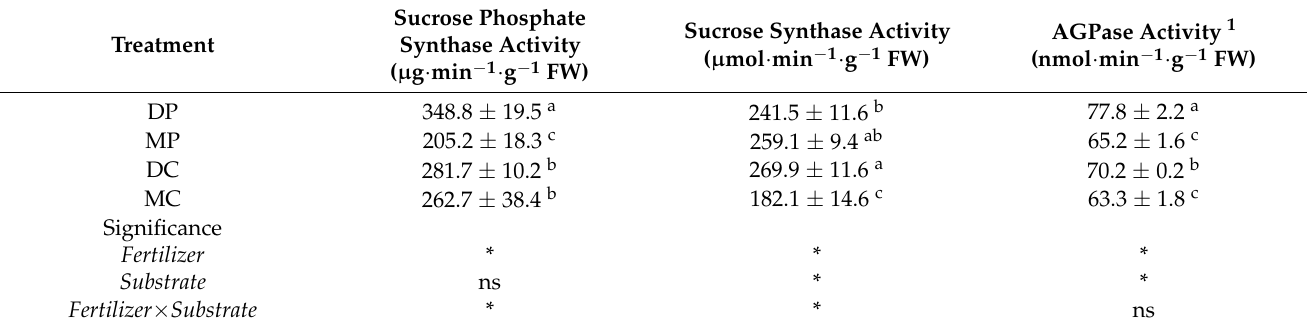
significantly influenced glucose, starch, sucrose phosphate synthase and sucrose synthase. Table 5. Effect of digested pig slurry on carbohydrate contents in leaves at 30-d fruit age. Table 6. Effect of digested pig slurry on the activities of carbohydrate metabolism enzymes in tomato Treatment leaves at 30-d fruit